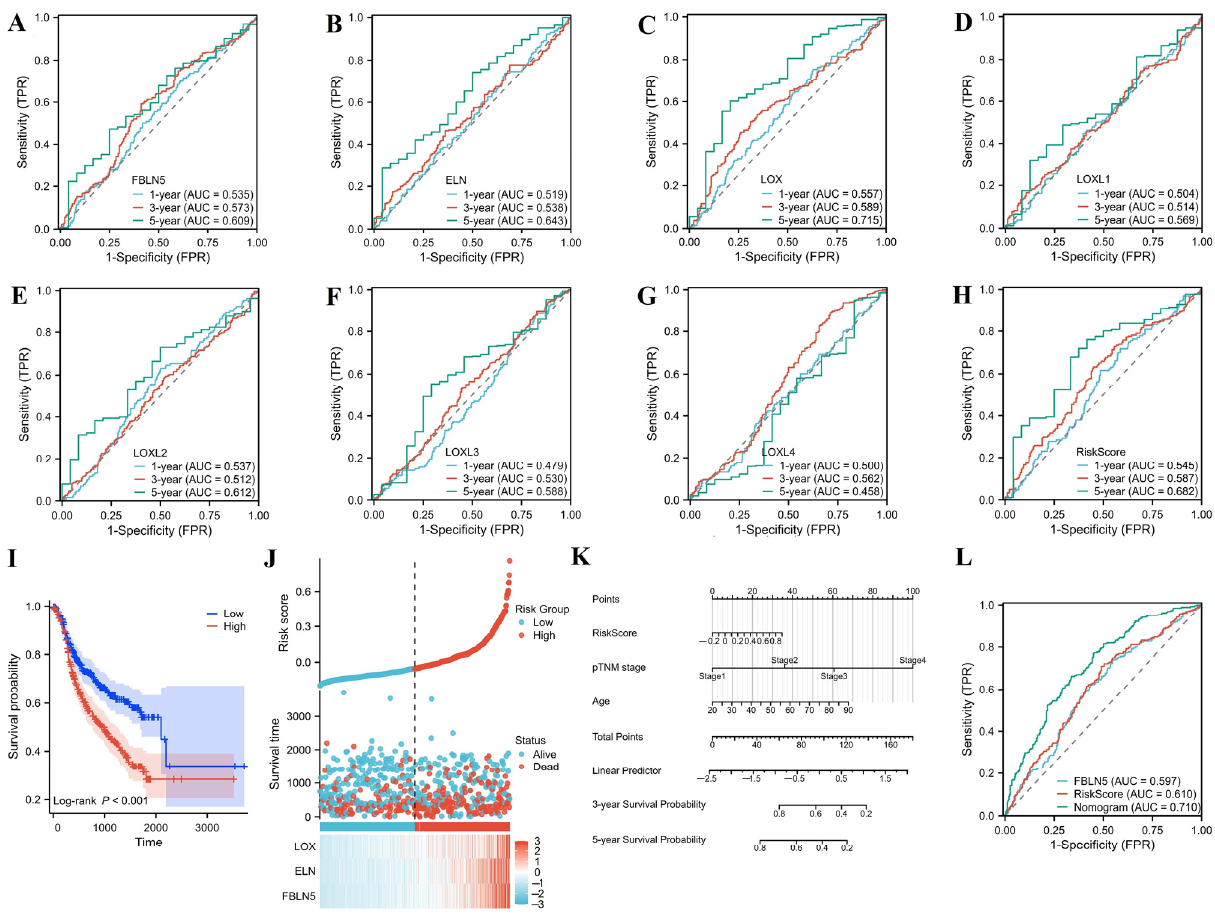
Figure 3. Predicting the prognosis of GC patients based on the mRNA expression levels of FBLN5. ( A – G ) ROCs analyzed the prognostic ability of FBLN5, ELN, LOXL1, LOXL2, LOXL3, and LOXL4 mRNA expression levels. ( H ) Prognostic risk score for FBLN5 expression, ELN expression, and LOX expression. ( I ) Assessment of the patient’s OS based on a prognostic risk score. ( J ) Risk factor graph to visualize the trend of prognostic model. ( K ) Nomogram prediction model based on risk score, pTNM stage, and age. ( L ) ROC analysis based on FBLN5 expression, risk score, and nomograph prediction model. ( OS: overall survival ).